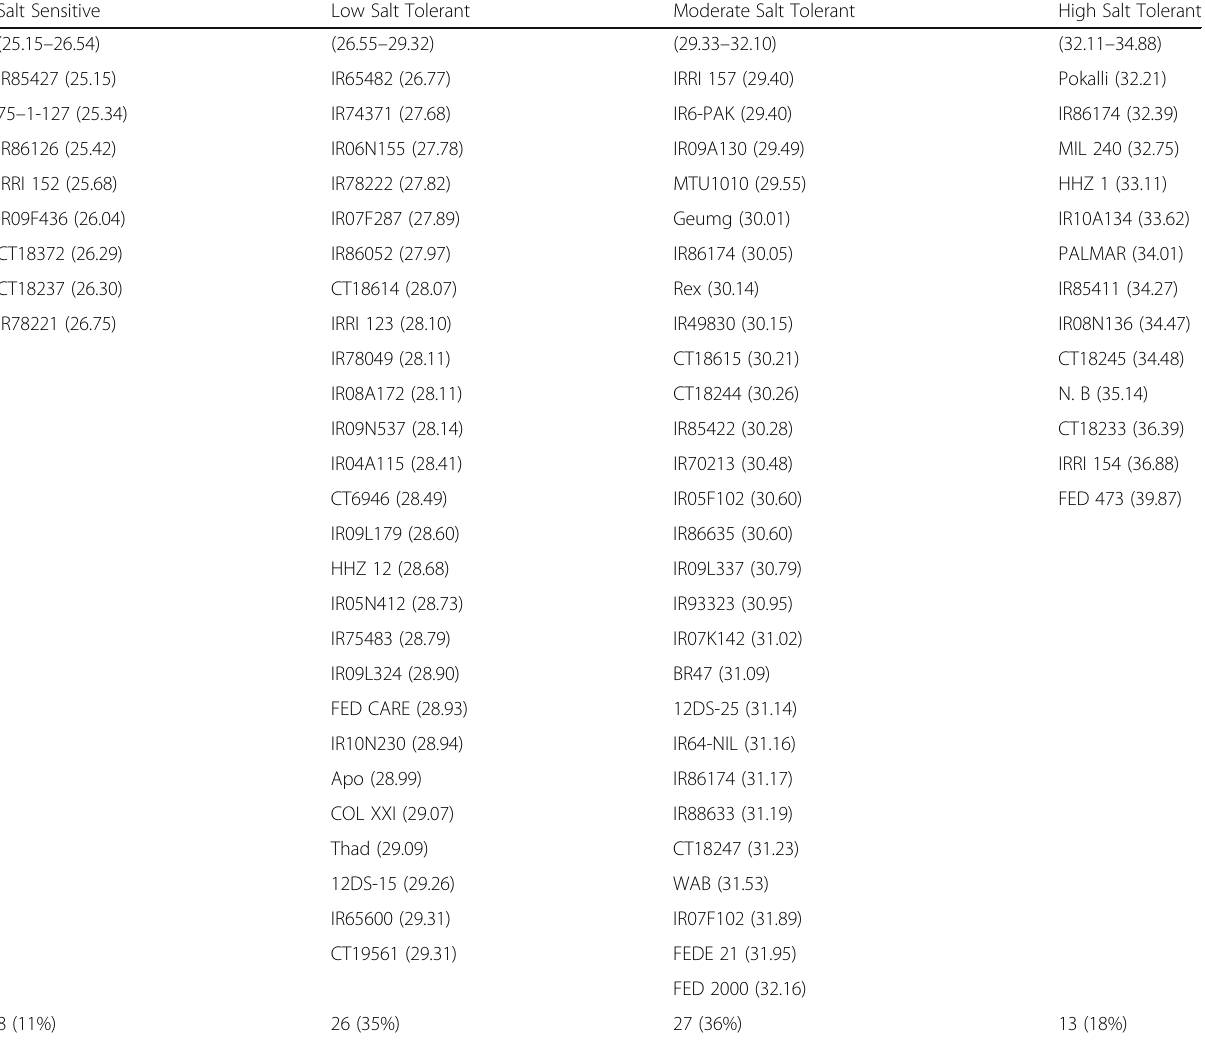
Table 2 Classification of 74 rice genotypes using total salt stress response indices (TSSRI) of morpho-physiological parameters at the seedling stage. Values of TSSRI are given in the parenthesis Salt